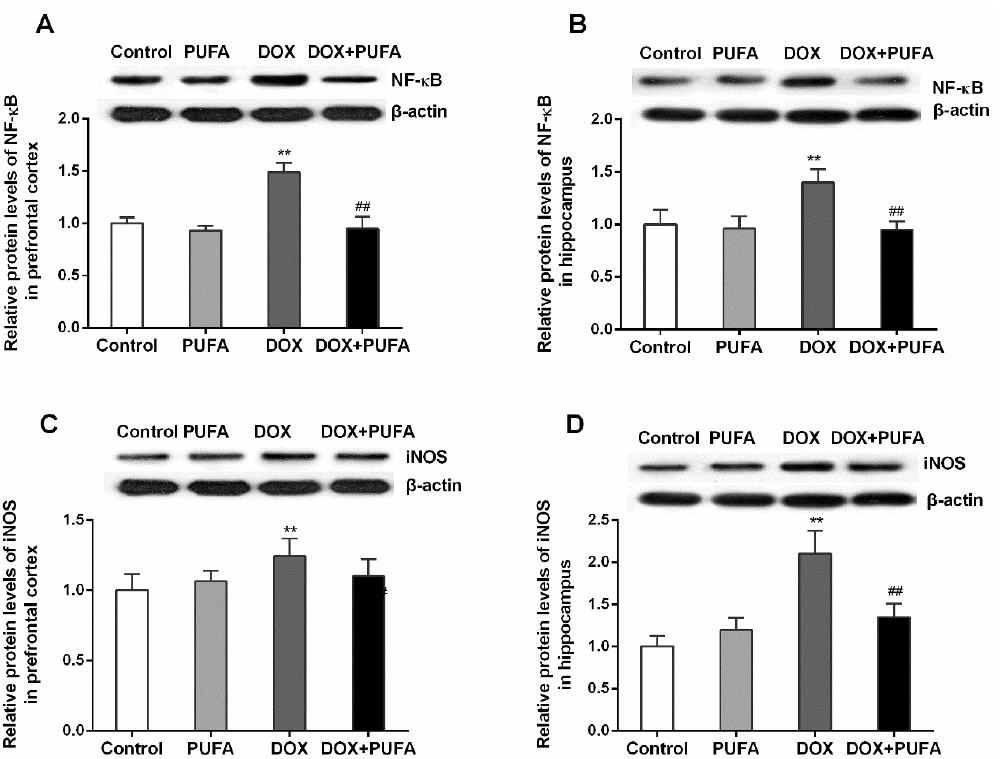
Figure 4. Effects of DOX and ω‐ 3 PUFAs on protein expression of NF ‐κ B and iNOS in the prefrontal